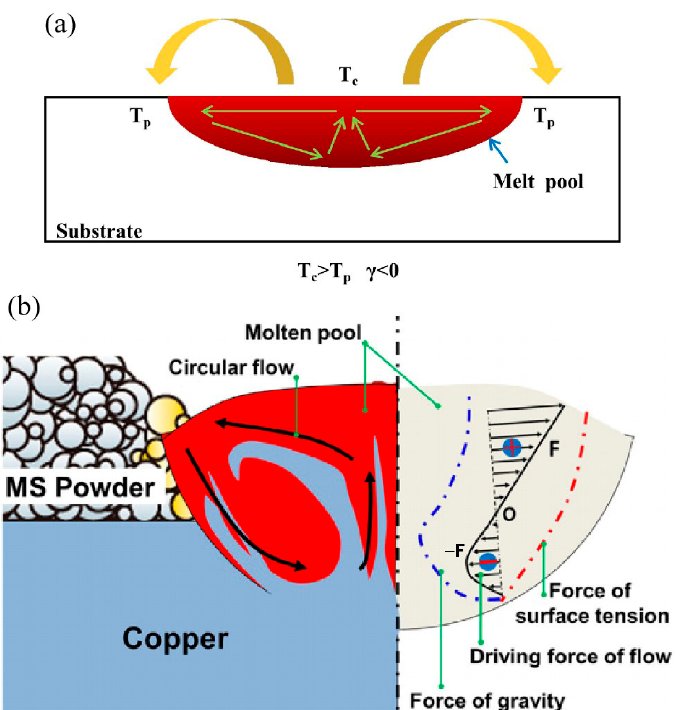
Figure 14. Schematic of ( a ) Marangoni convection induced by surface tension; ( b ) Corresponding formation mechanism in melt pool at the interface of maraging steel/Cu [103].